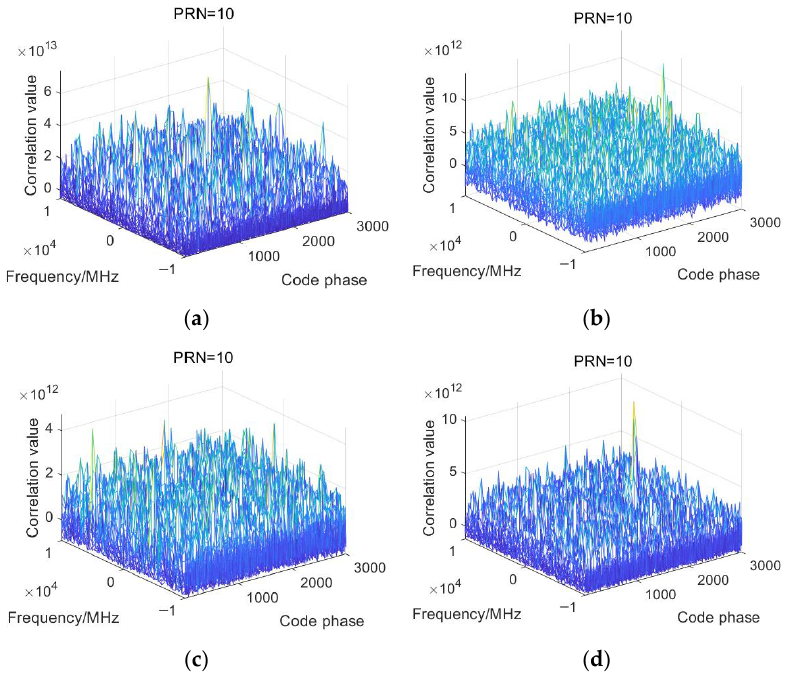
Figure 9. SIR = − 38 dB, acquisition effect of the four algorithms: ( a ) coherent integration; ( b ) coherent and non-coherent integration; ( c ) differential coherent integration; and ( d ) improved differential coherent